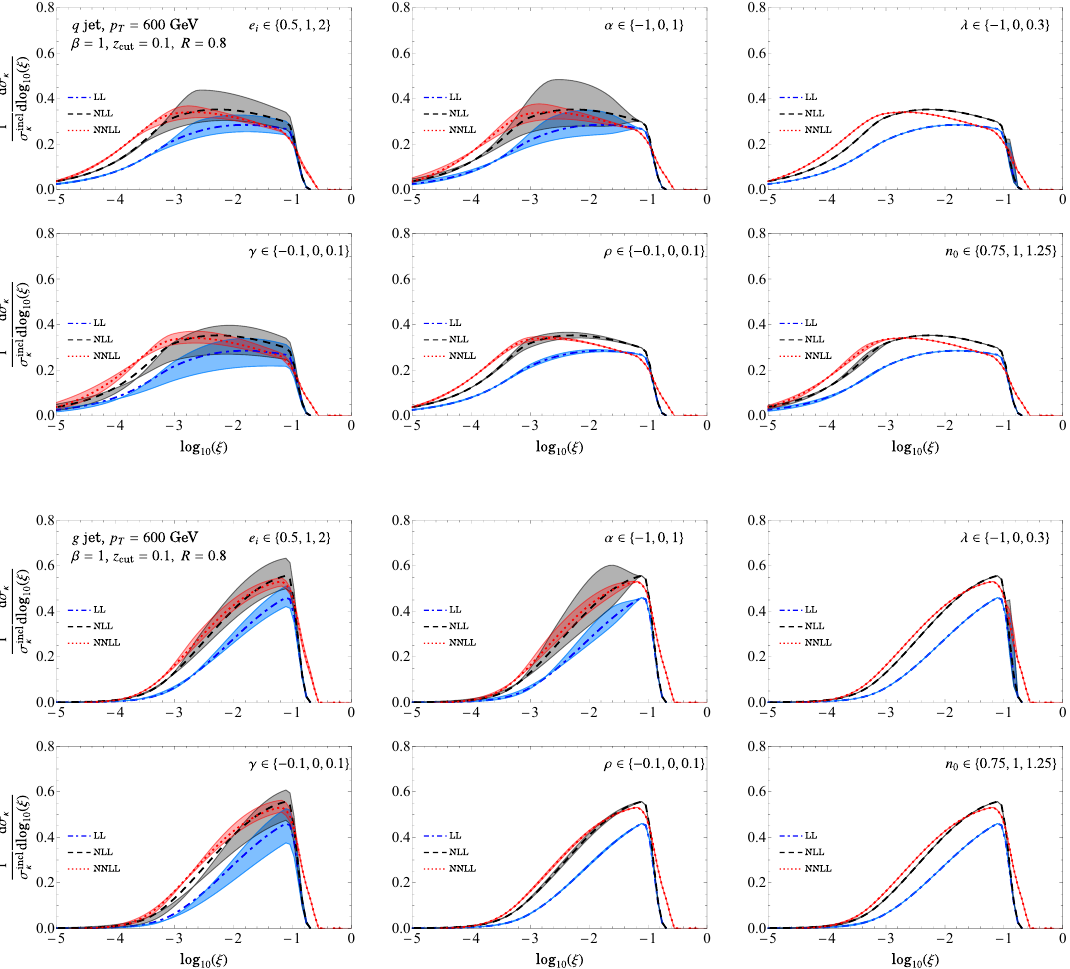
Figure 5 . Variations for each of the six different profile-variation parameters individually, for quark and gluon jets at p = 600 GeV, with β = 1 . Other values of β are shown in appendix E. T